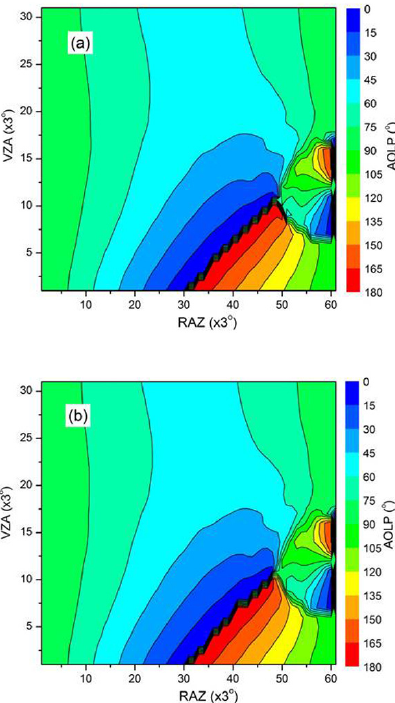
Fig. 21. Same as in Fig. 20, but for the AOLPs of the ocean– atmosphere system with water clouds of optical thickness (a) 5.0 and (b) 10.0, respectively.